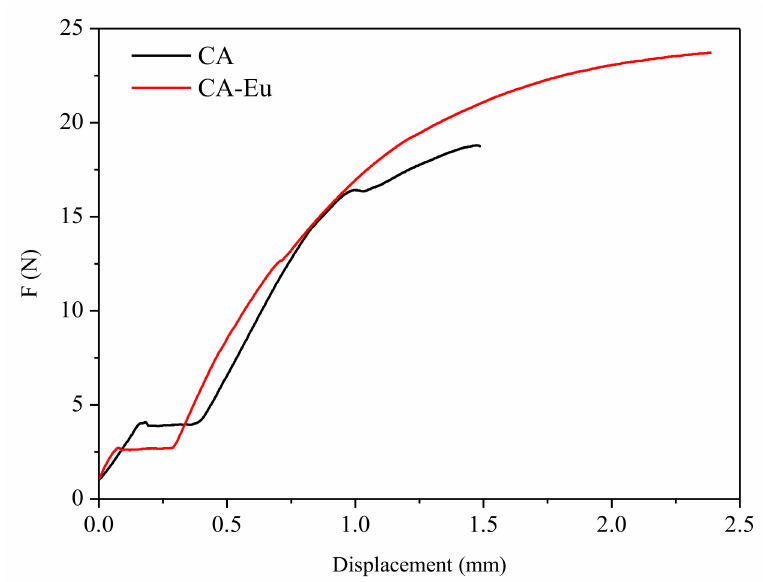
Figure 8. The load-displacement curves of CA and CA–Eu films. Table 3. The mechanical properties of CA film and CA-Eu light conversion film.